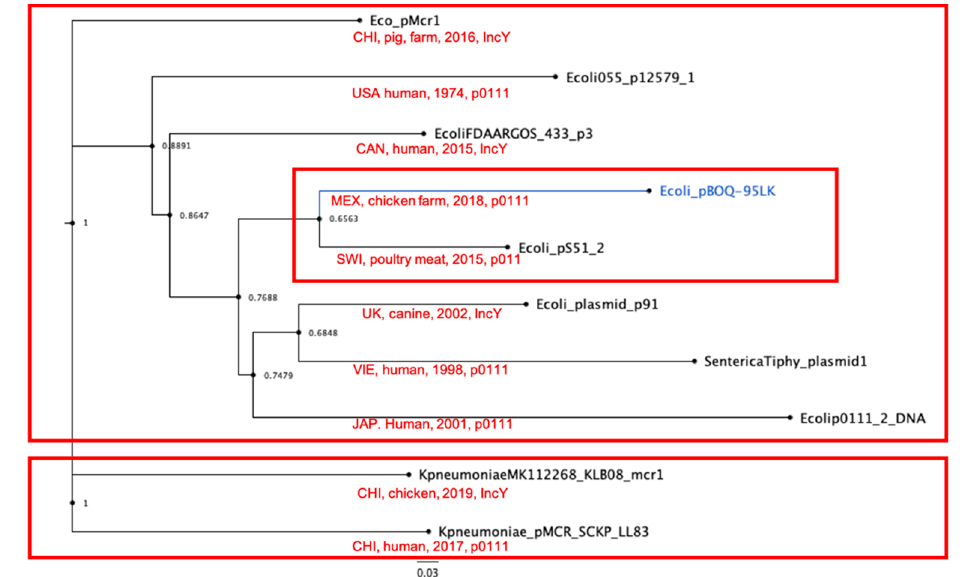
Figure 6. Phylogenomic trees of phage-like plasmids. Phylogenomic tree using 41 concatenated genes present in all plasmids (core plasmid genome) using Maximum Likelihood inference and the Bayesian posterior probability.